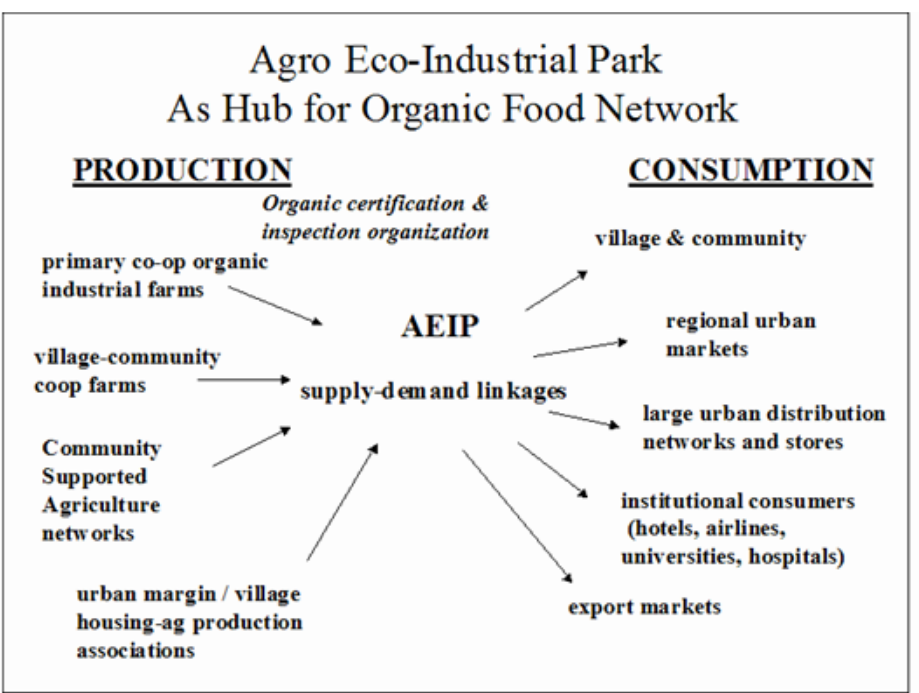
Figure 3. The concept of Agro Eco-Industrial Parks